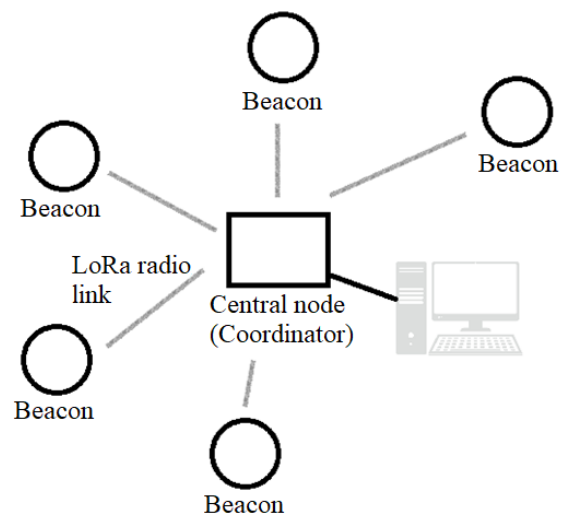
Figure 6. Beacon network configuration.